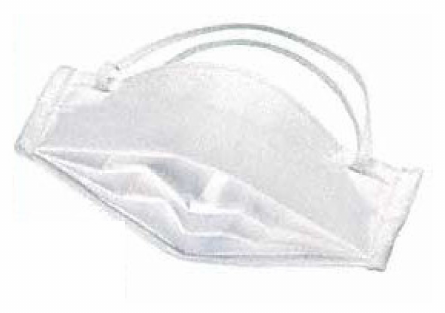
Figure 4. N95 pleated respirator.